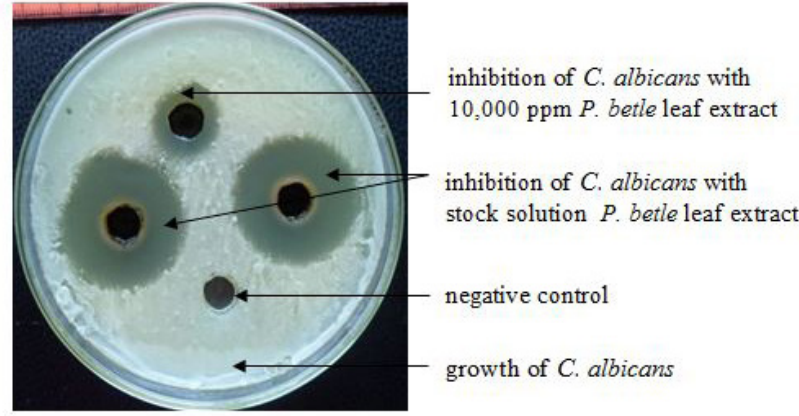
Figure 2: Zones of inhibition of C. albicans with different concentrations of P. betle leaf